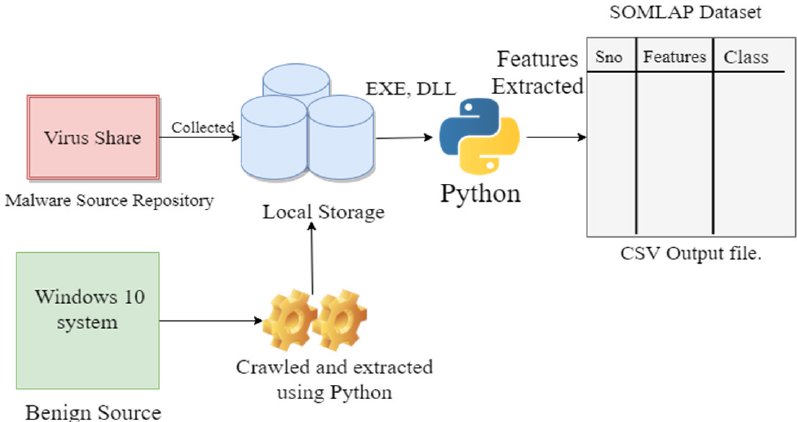
Figure 2. SOMLAP data extraction process.